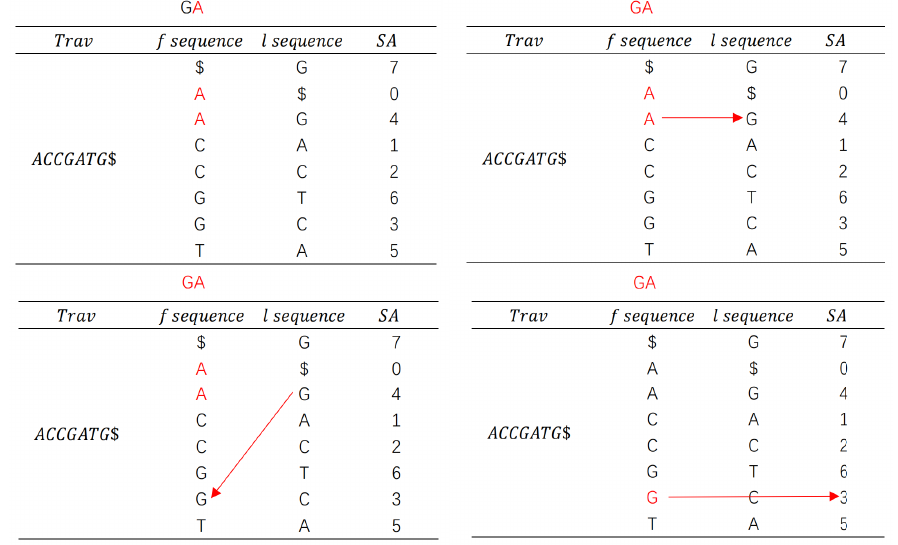
Figure 4. FM index matching